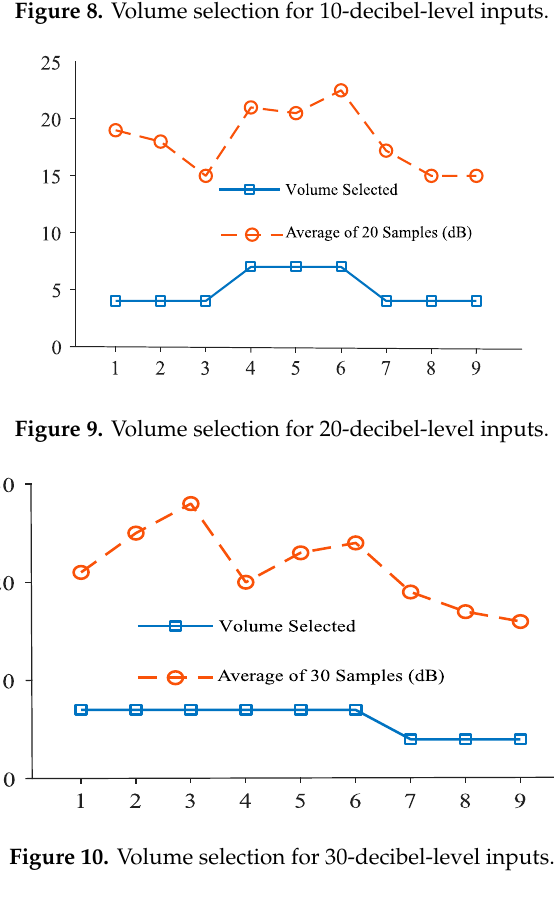
Sensors 2020 , 20 , x FOR PEER REVIEW Figure 8. Volume selection for 10-decibel-level inputs. Figure 8. Volume selection for 10-decibel-level inputs.